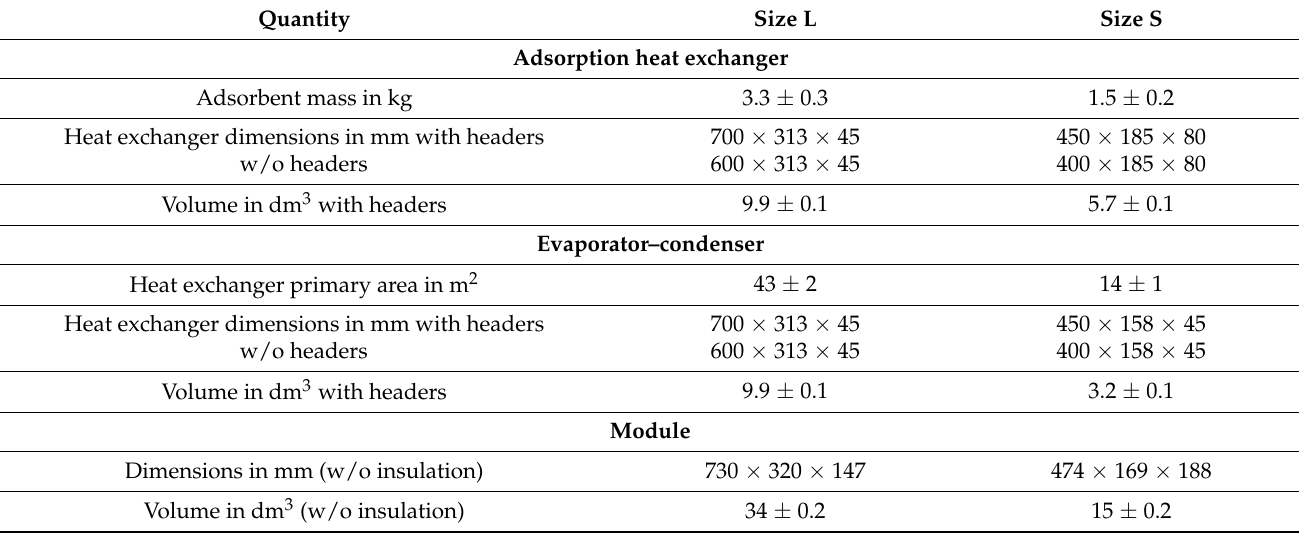
Table 1. Main data of the components and the modules.